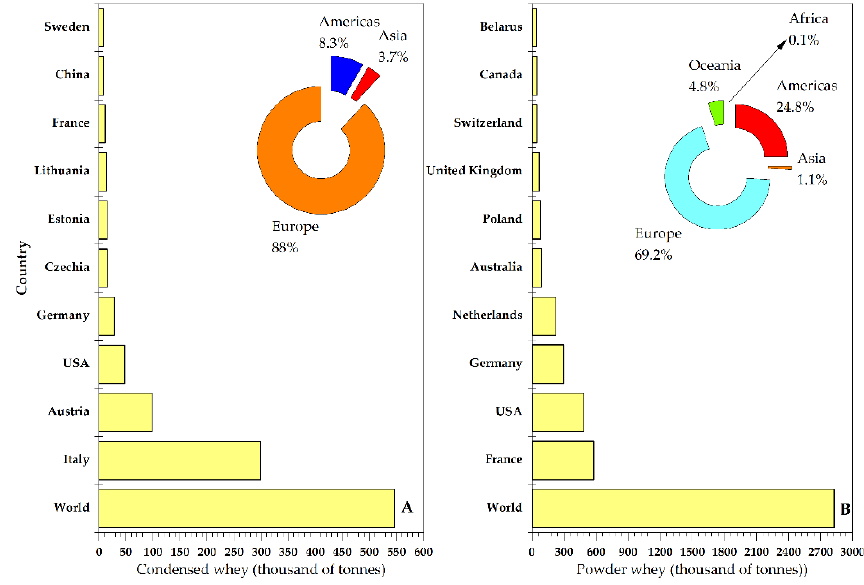
Figure 3. World cheese whey production: ( A ) Top ten condensed cheese whey producer countries and production distribution per region, ( B ) Top ten powder cheese whey producer countries and production distribution per region.